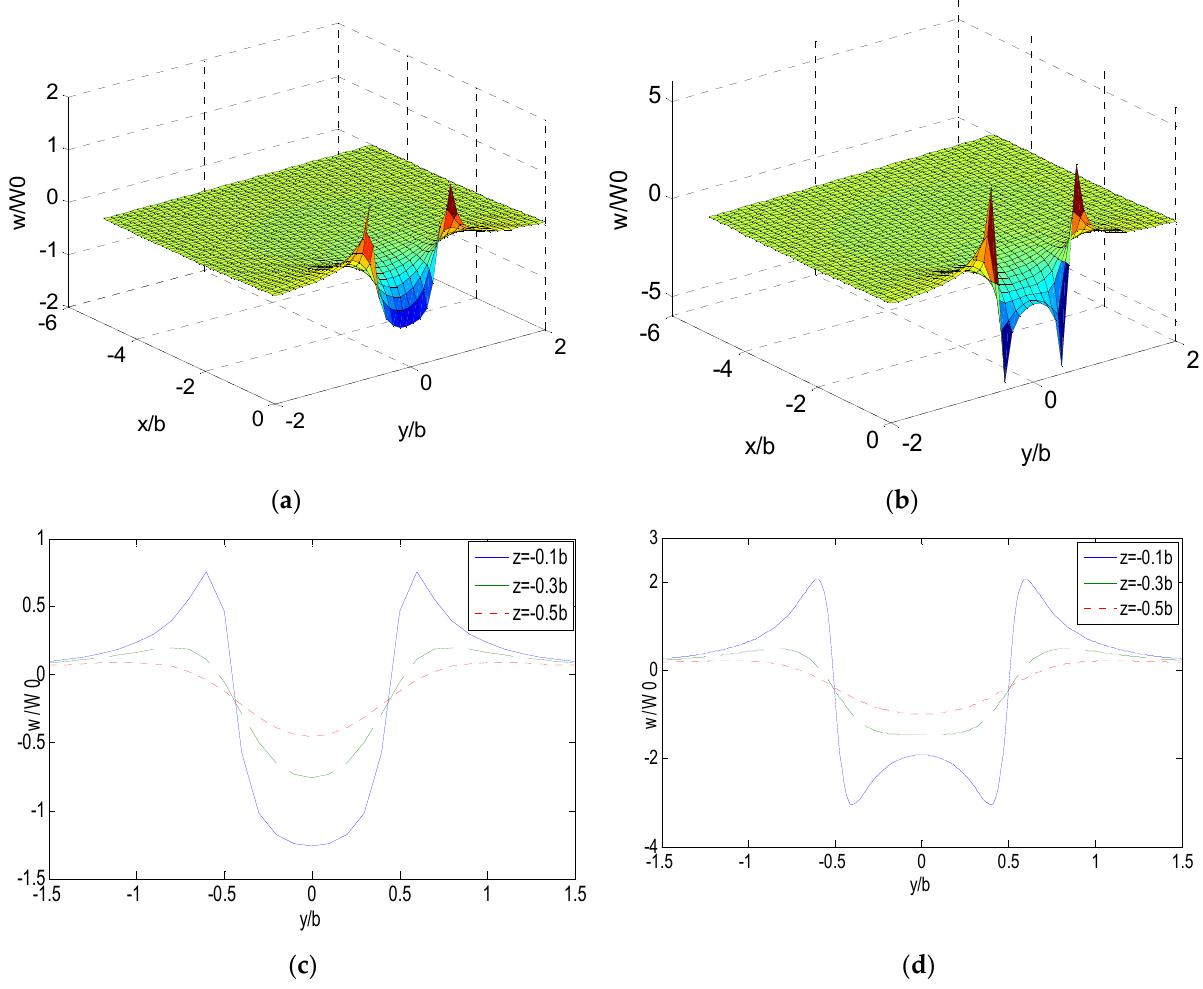
Figure 4. Induced vertical velocity distribution under a wing with the elliptic and rectangular lift distribution: ( a ) yz plane at x = 0 with elliptic lift; ( b ) yz plane at x = 0 with rectangular lift; ( c ) z = − 0.1 b , − 0.3 b , − 0.5 b on yz plane ( x = 0) with elliptic lift; ( d ) z = − 0.1 b , − 0.3 b , − 0.5 b on yz plane ( x = 0) with rectangular lift.